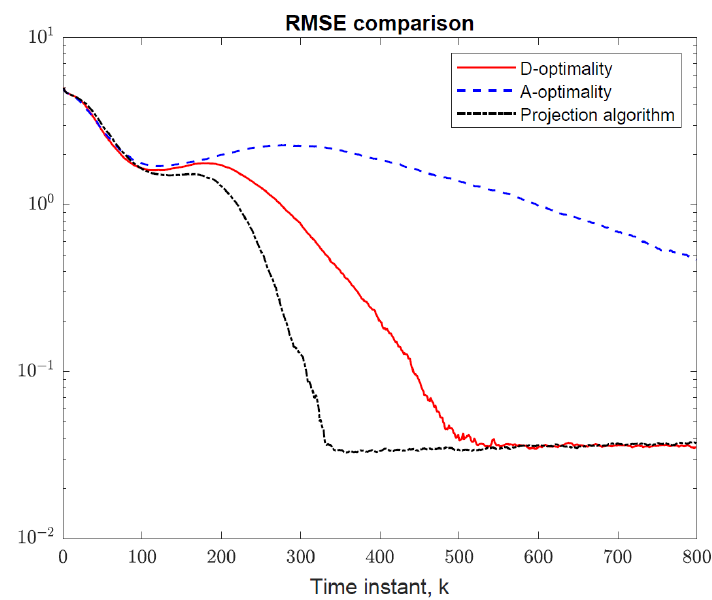
Figure 12. RMSE comparison of sensor trajectory optimization methods. The projection algorithm minimizes target tracking error fastest, followed by the D-optimality